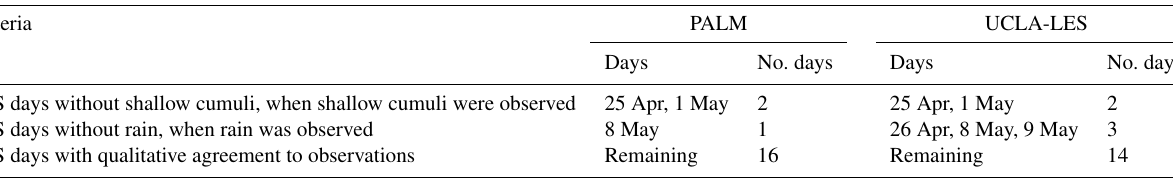
Table 2. Summary on qualitative agreement in the principal character of the simulated days compared to Cloudnet and the HOPE weather overview archive.